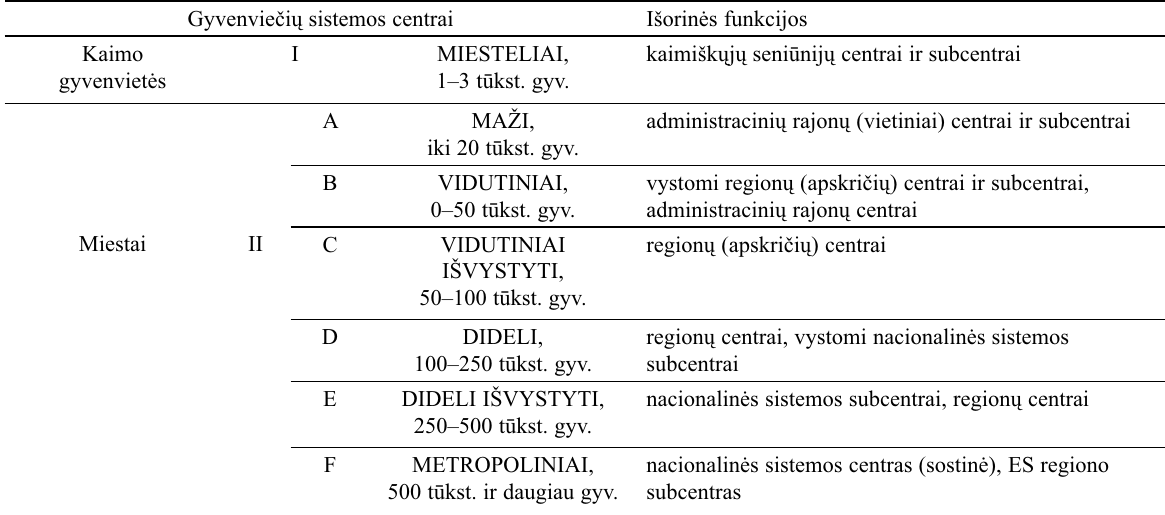
Table 1. Classification of settlement system centres